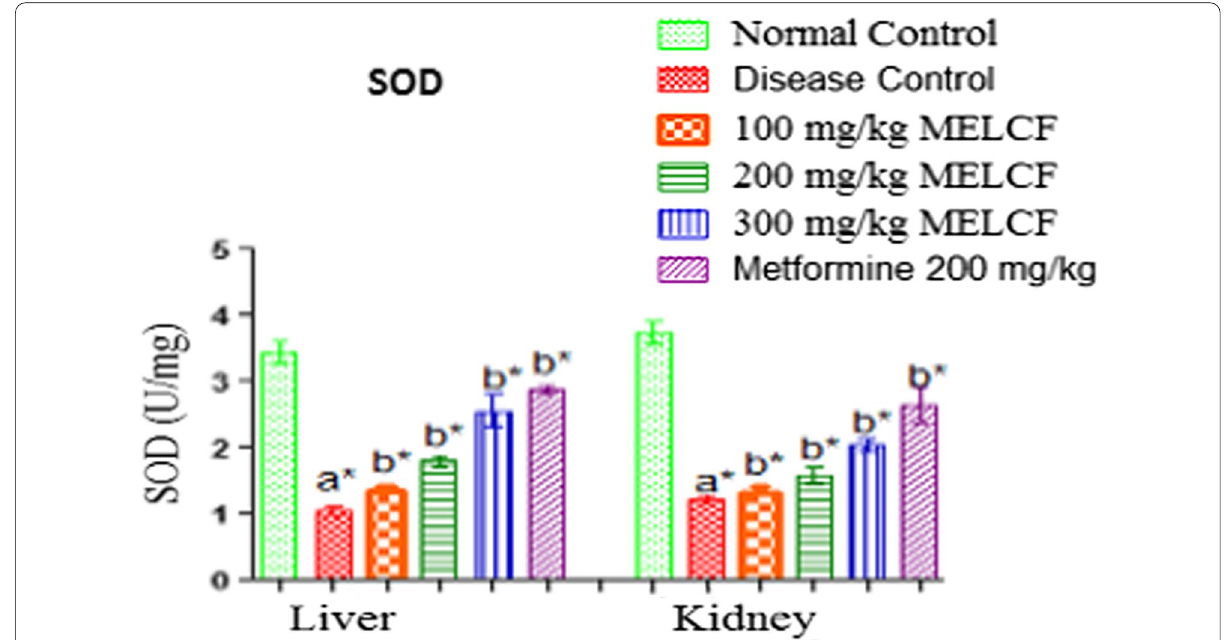
SEM ( n 6). a* ( p < 0.05) when compared to normal control and b* ( p < 0.05) ± =